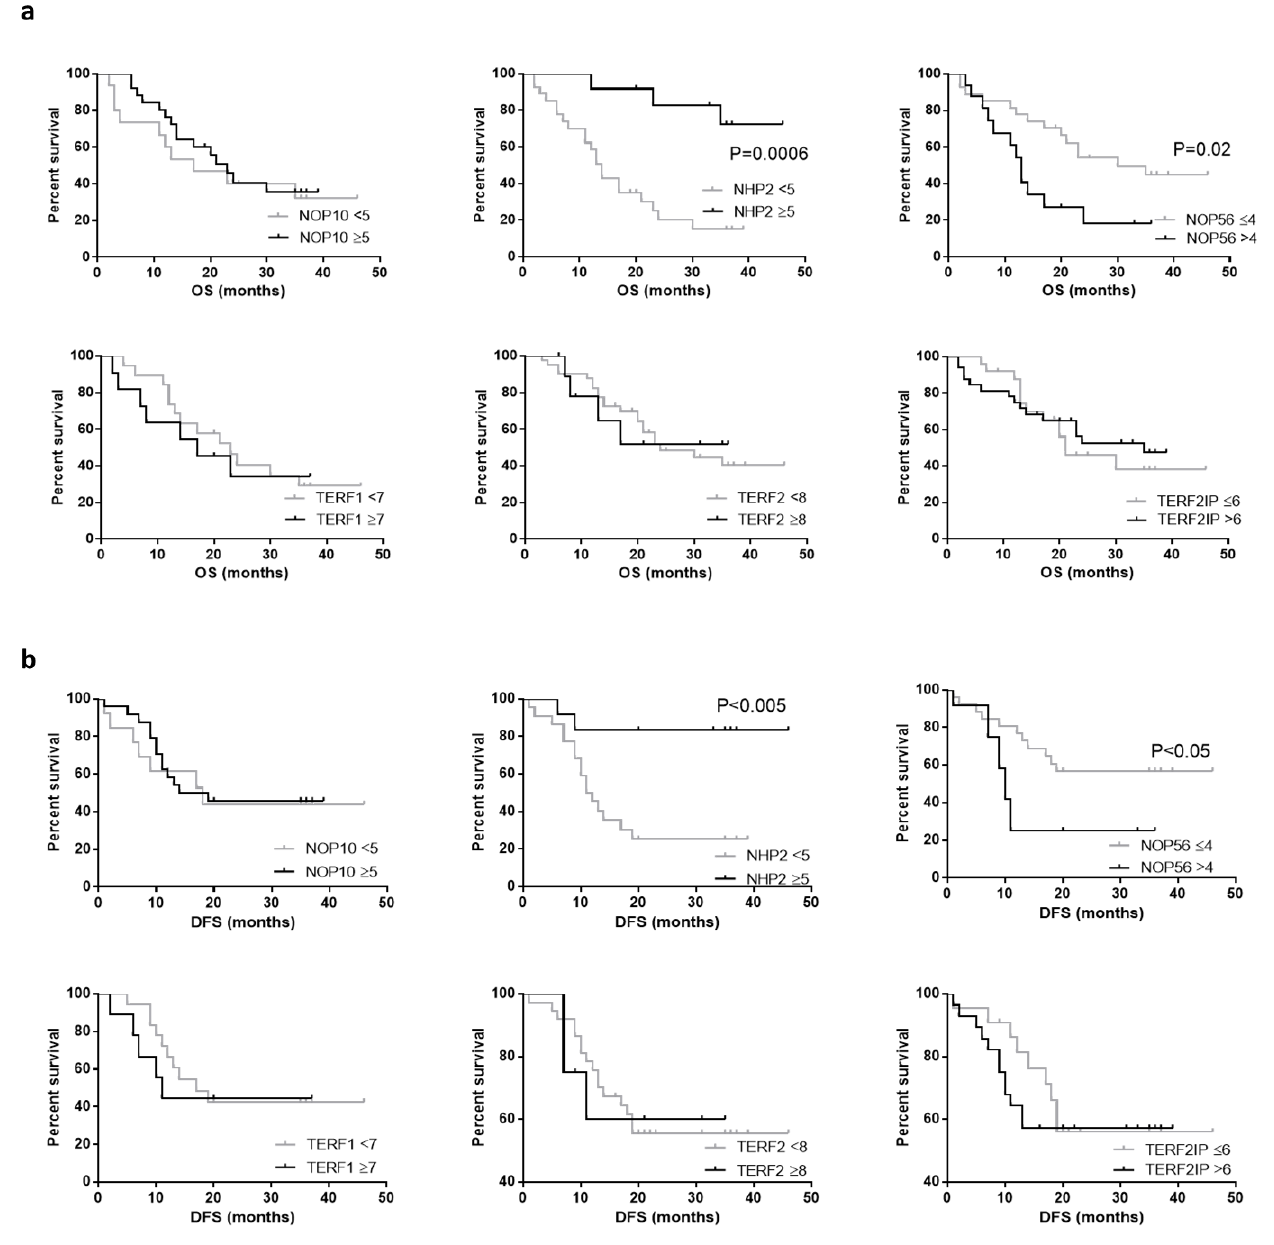
Figure 5. Survival curves obtained from IHC Quickscores of experimental data. Low quickscore data shown in grey, high quickscore data in black. ( a ) Overall survival (OS). Low NOP10 n = 15, high NOP10 n = 26, p = 0.56; low NHP2 n = 27 median survival 14 months, high NHP2 n = 12, median survival undefined, p = 0.0006; low NOP56 n = 27, median survival 30 months, high NOP56 n = 16 median survival 16 months, p = 0.02; low TERF1 n = 19, high TERF1 n = 11, p = 0.78; low TERF2 n = 41, high TERF2. n = 11, p = 0.97; low TERF2IP n = 25, high TERF2IP n = 33, p = 0.69. ( b ) Disease-free survival (DFS). Low NOP10 n = 15, high NOP10 n = 26, p = 0.8; low NHP2 n = 27 median DFS 11.5 months, high NHP2 n = 12, median DFS undefined, p < 0.005; low NOP56 n = 27, median DFS undefined, high NOP56 n = 16 median DFS 10 months, p < 0.05; low TERF1 n = 19, high TERF1 n = 11, p = 0.69; low TERF2 n = 41, high TERF2. n = 11, p = 0.96; low TERF2IP n = 25, high TERF2IP n = 33, p = 0.70.